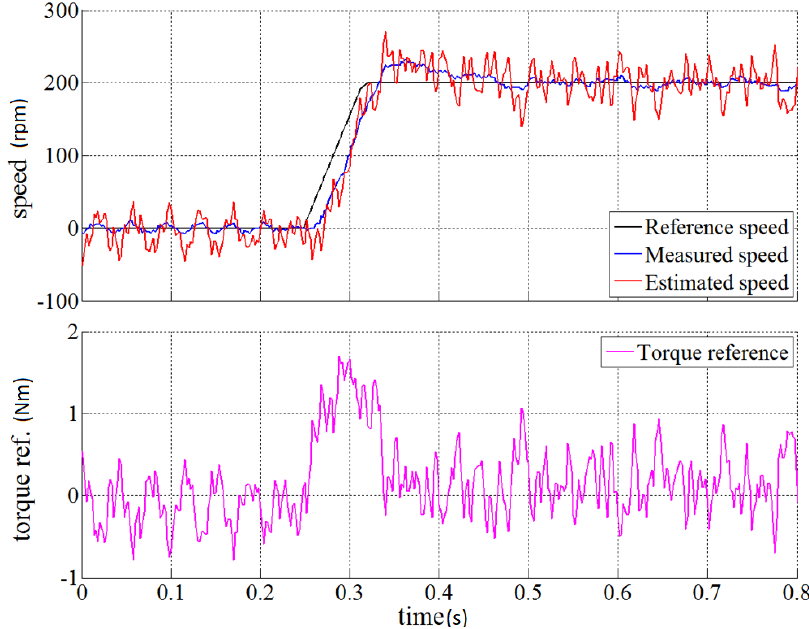
Figure 20. Motor #1: Increased bandwidth sensorless speed control (MTPA), startup from 0 to 200 rpm, proposed (self-adaptation) rotating voltage injection and 𝑖 𝑖1 regulation (150 mA), no load.